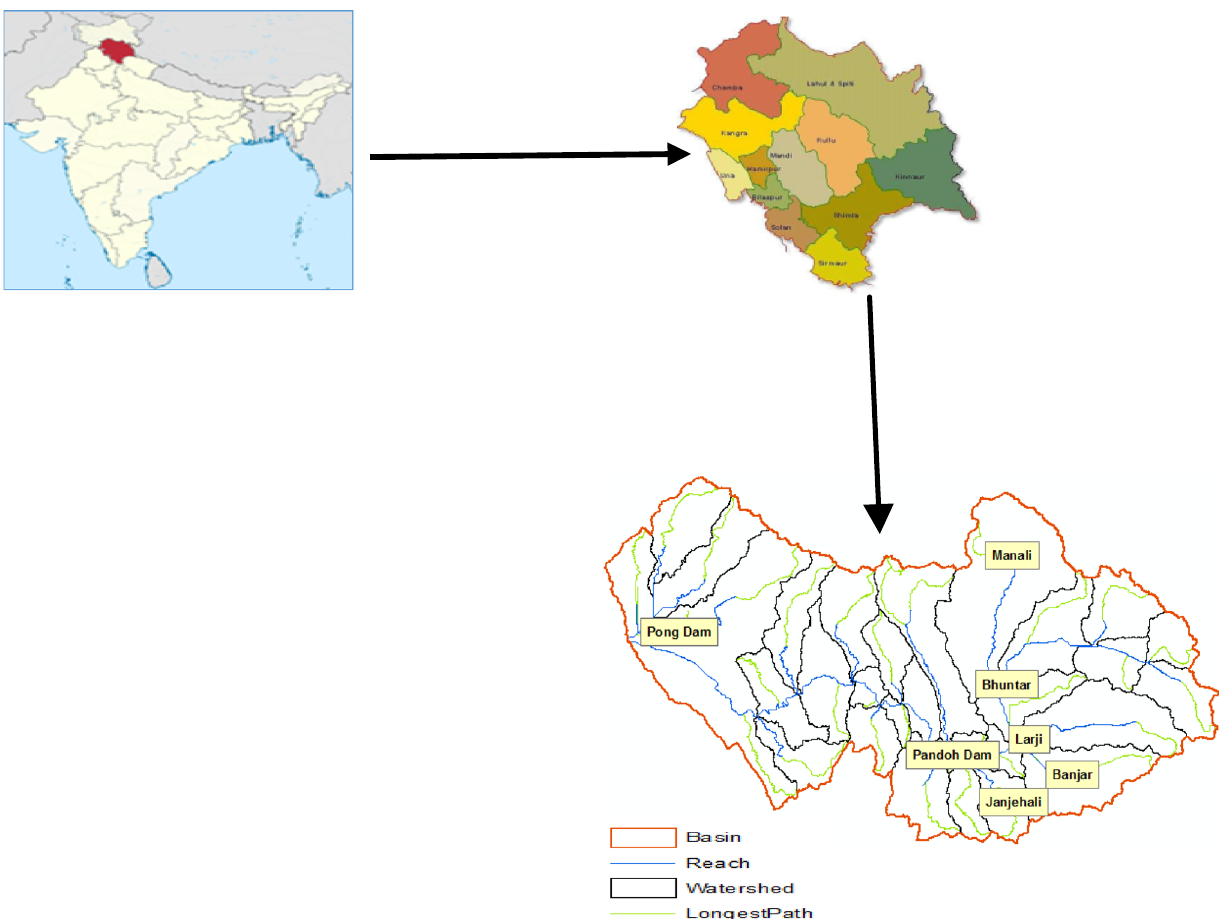
Fig. 1 Study area of Beas river